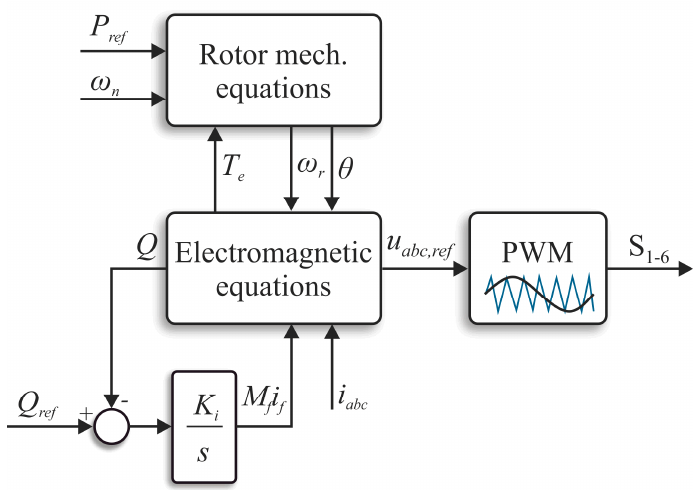
Figure 9. SSG/VSG inverter damping control.